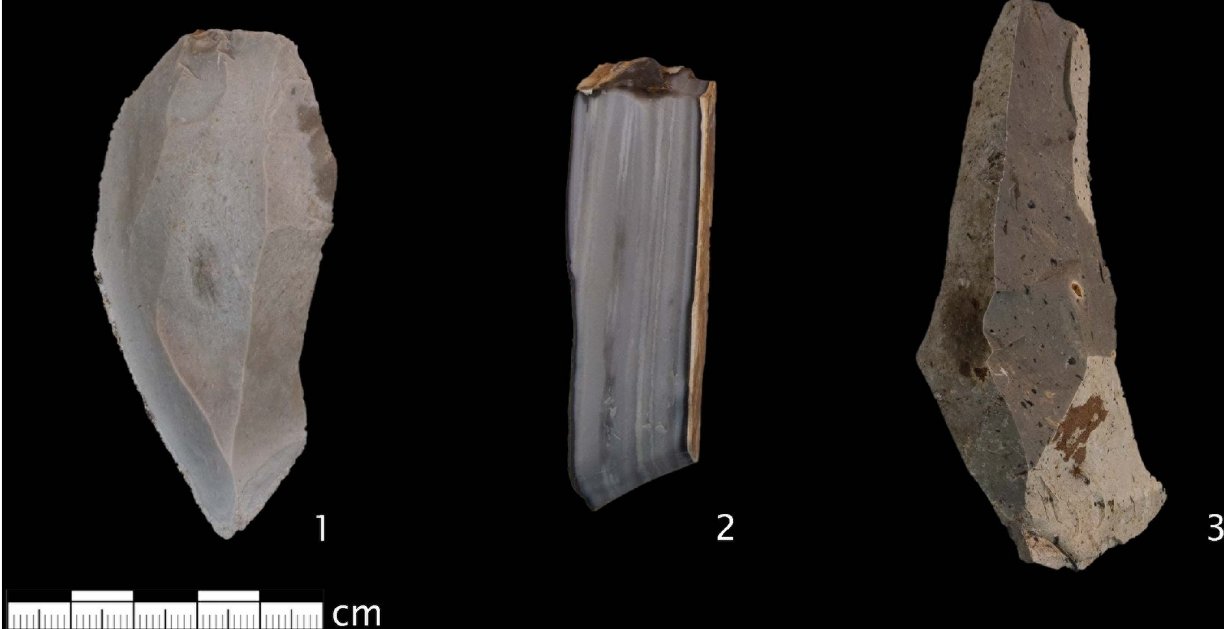
Fig 2. Chert from the three outcrops considered in this study. 1. Blaubeuren Blauberg, 2. Abensberg Arnhofen, 3. Randecker Maar. Photos taken by B. Schu¨rch.